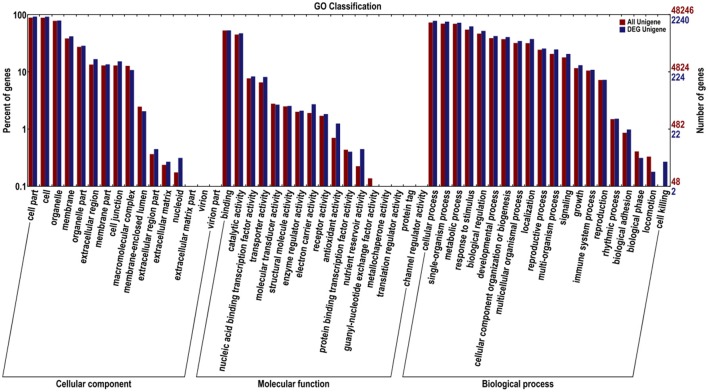
Gene Ontology (GO) functional classification of all Unigenes and differentially expressed (DEG) Unigenes in JL-08 and JL-09 sprouts. GO analysis was performed for the three main categories (cellular component, molecular function, and biological process). The X axis represented different categories of all Unigenes and differentially expressed Unigenes in JL-08 and JL-09 sprouts. The right Y axis indicates the numbers of all Unigenes and differentially expressed Unigenes in a specific category. The left Y axis indicates the percentage of a specific category of all Unigenes and differentially expressed Unigenes in a specific category. Red column, all Unigenes; Blue column, DEG Unigenes.